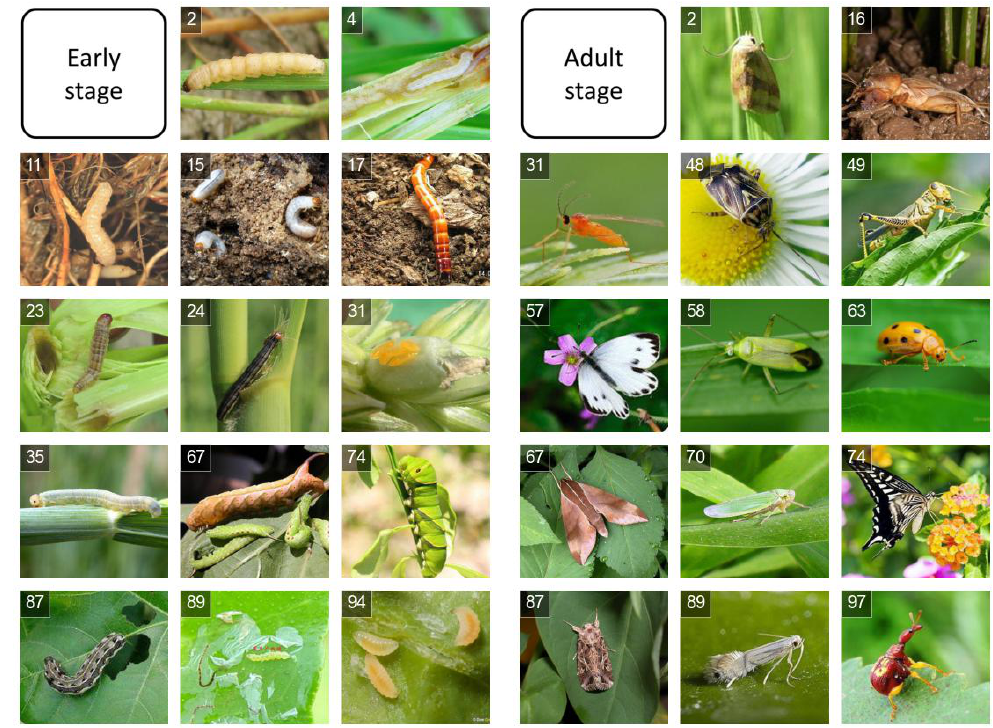
Figure 3. Some samples from the IP-FSL data set. Class labels refer to the numbers in Table 1. Some examples of classes with two maturity stages (adult and early, appearing in both subsets, classes 2, 31, 67, 74, 87, and